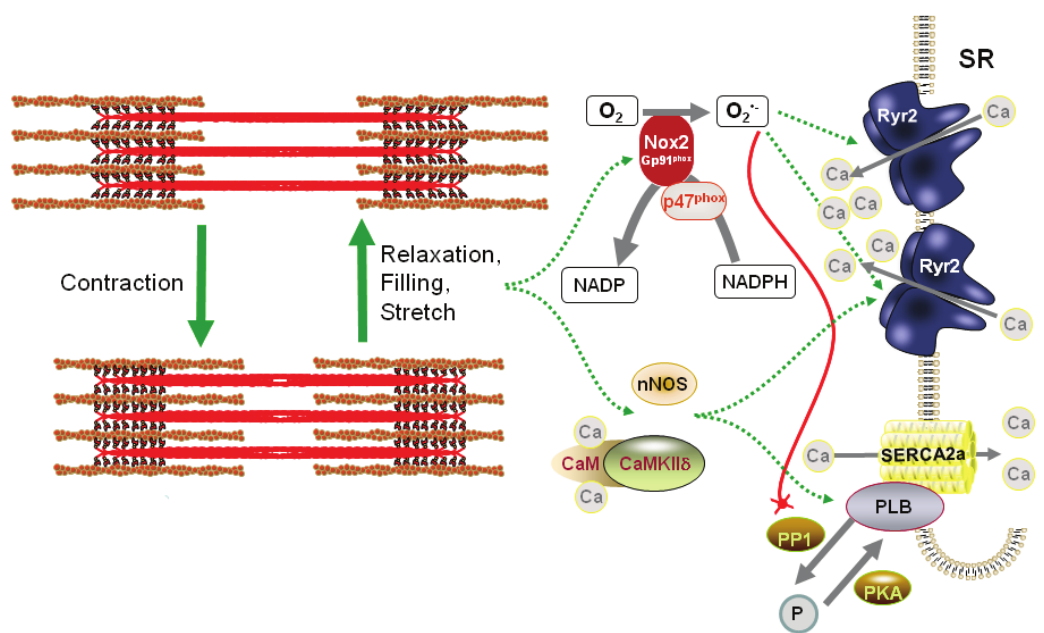
Figure 5. Stretching cardiac myocytes activates NOX2 in discrete locations in the cell to sensitise Ryr2 and increase Ca spark activity. Phospholamban (PLB) phosphorylation that enhances SR Ca uptake occurs by ROS-mediated (O